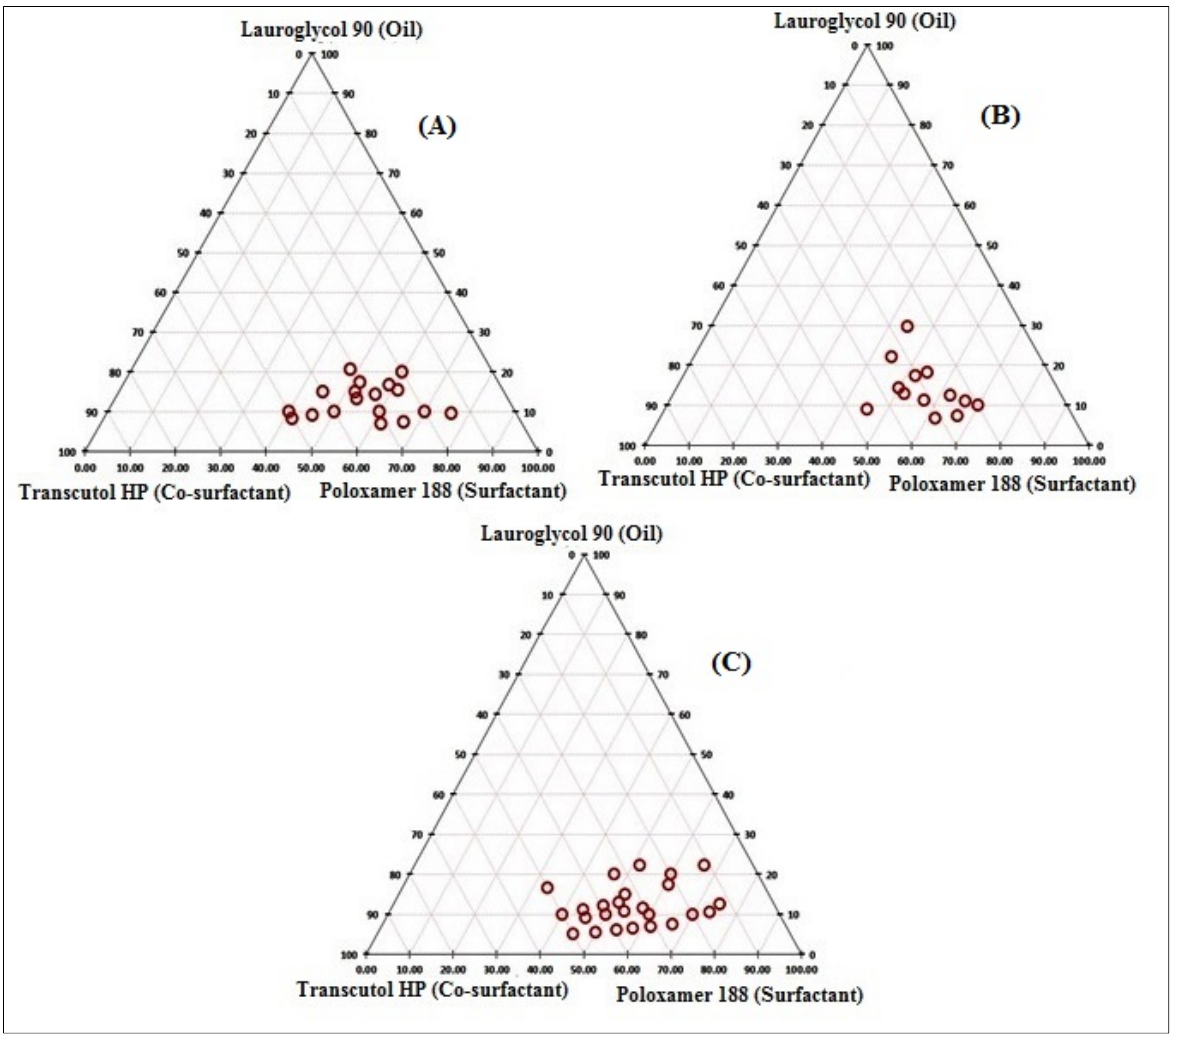
Figure 2. Pseudo ternary phase diagram of different Smix ratios: ( A ). 1:1; ( B ) 1:2; ( C ). 2:1.